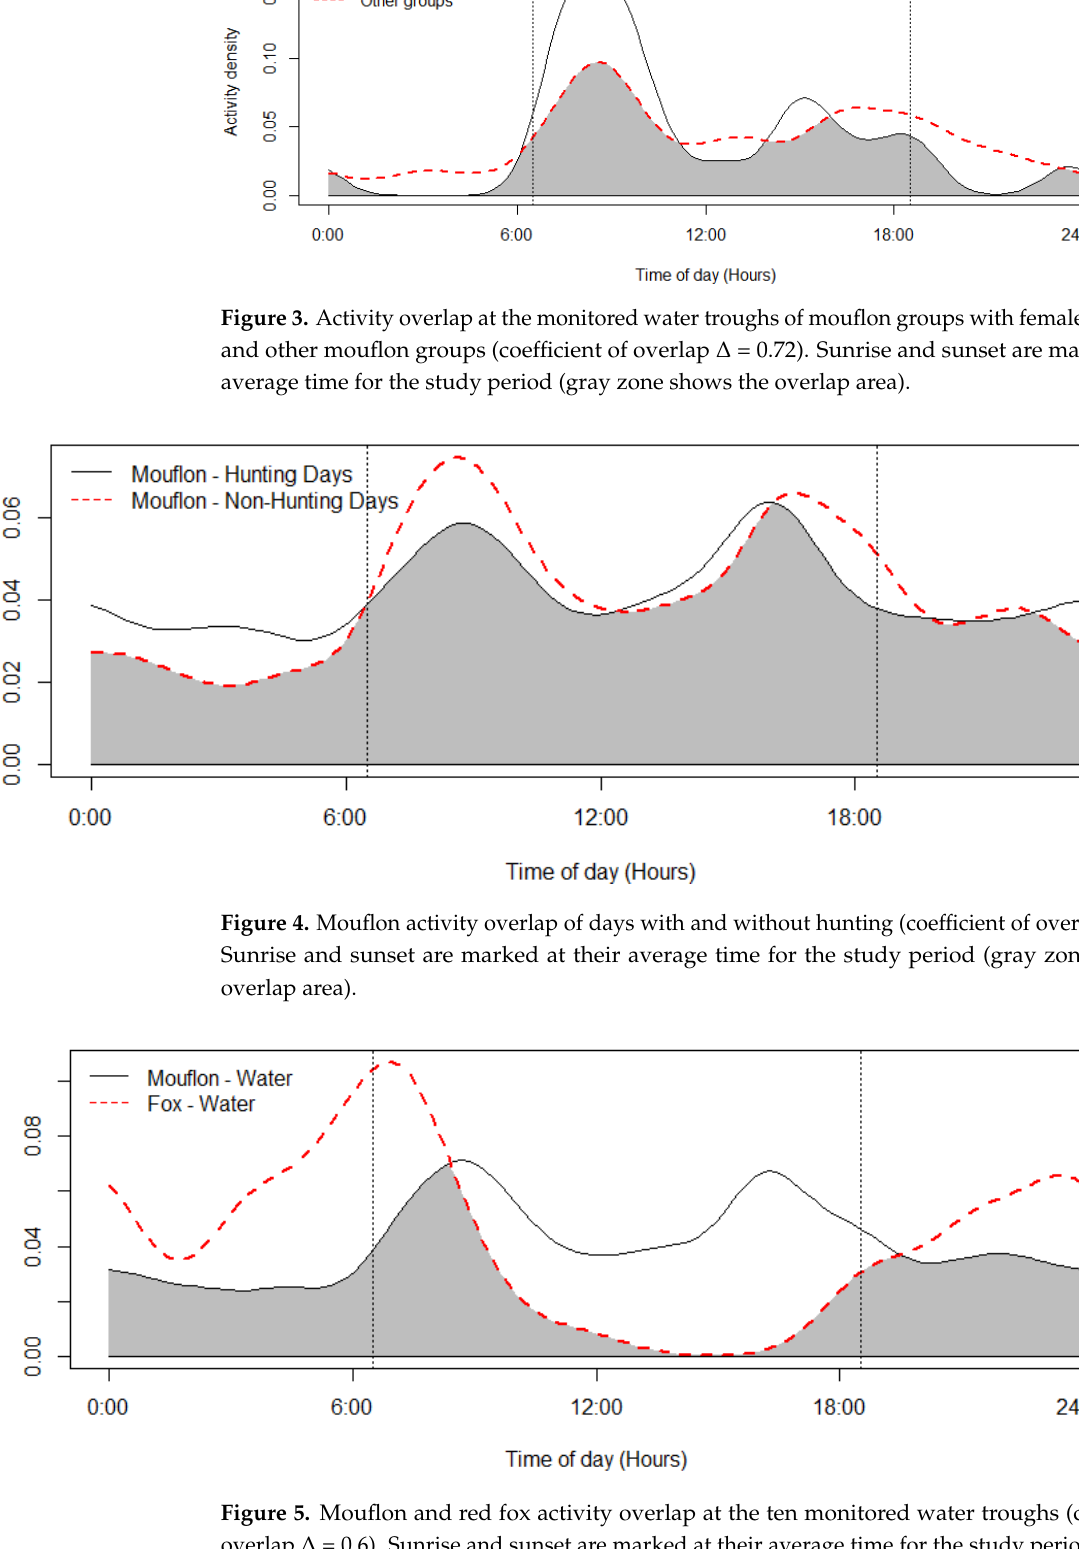
Figure 5. Mouflon and red fox activity overlap at the ten monitored water troughs (coefficient of overlap Δ = 0.6). Sunrise and sunset are marked at their average time for the study period (gray zone shows the overlap area).